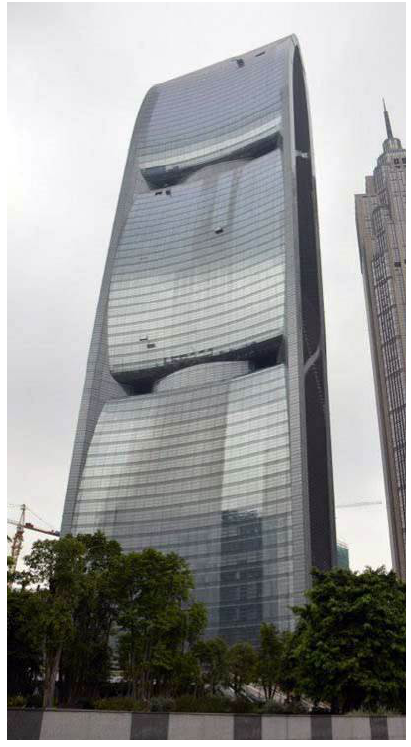
Figure 10. Pearl River Tower (courtesy of Terri Meyer